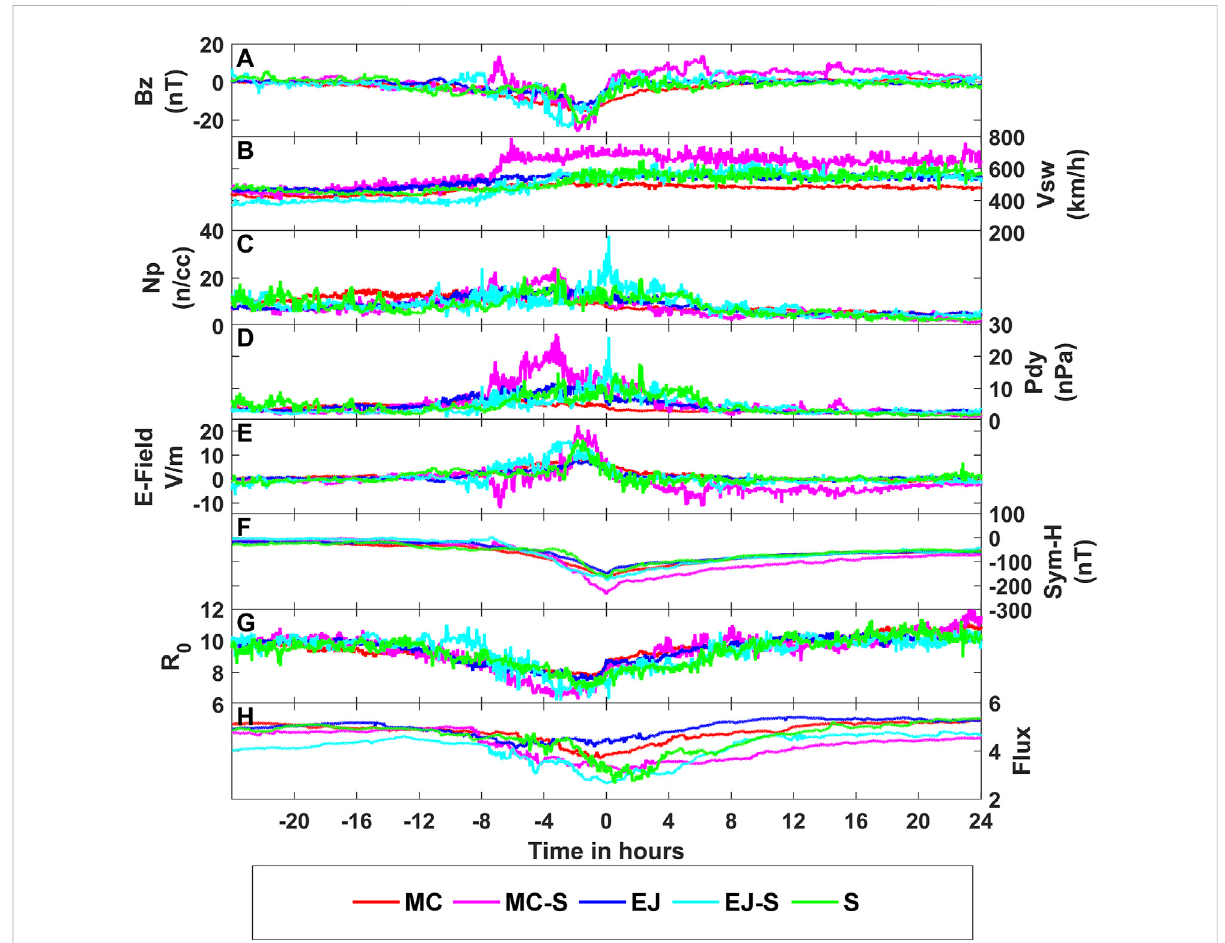
FIGURE 2 Superposed epochanalysis performed on thevarious interplanetaryconditions: (A) IMF Bz (nT), (B) solar wind speed, Vsw (km/h), (C) solar wind density, Np (n/cc), (D) solar wind dynamic pressure, Pdy (nPa), (E) electric fi eld (V/m), (F) Sym-H (nT), (G) magnetopause stand-off distance, R 0 (R E ), and (H) GOES > 0.6 MeVelectron fl ux(ecm − 2 s − 1 sr − 1 )fordifferentsolarsubstructuressuchasmagneticcloud(MC),magneticcloudwithsheath(MC- S), ejecta (EJ), ejecta with sheath (EJ-S), and sheath (S) represented by different